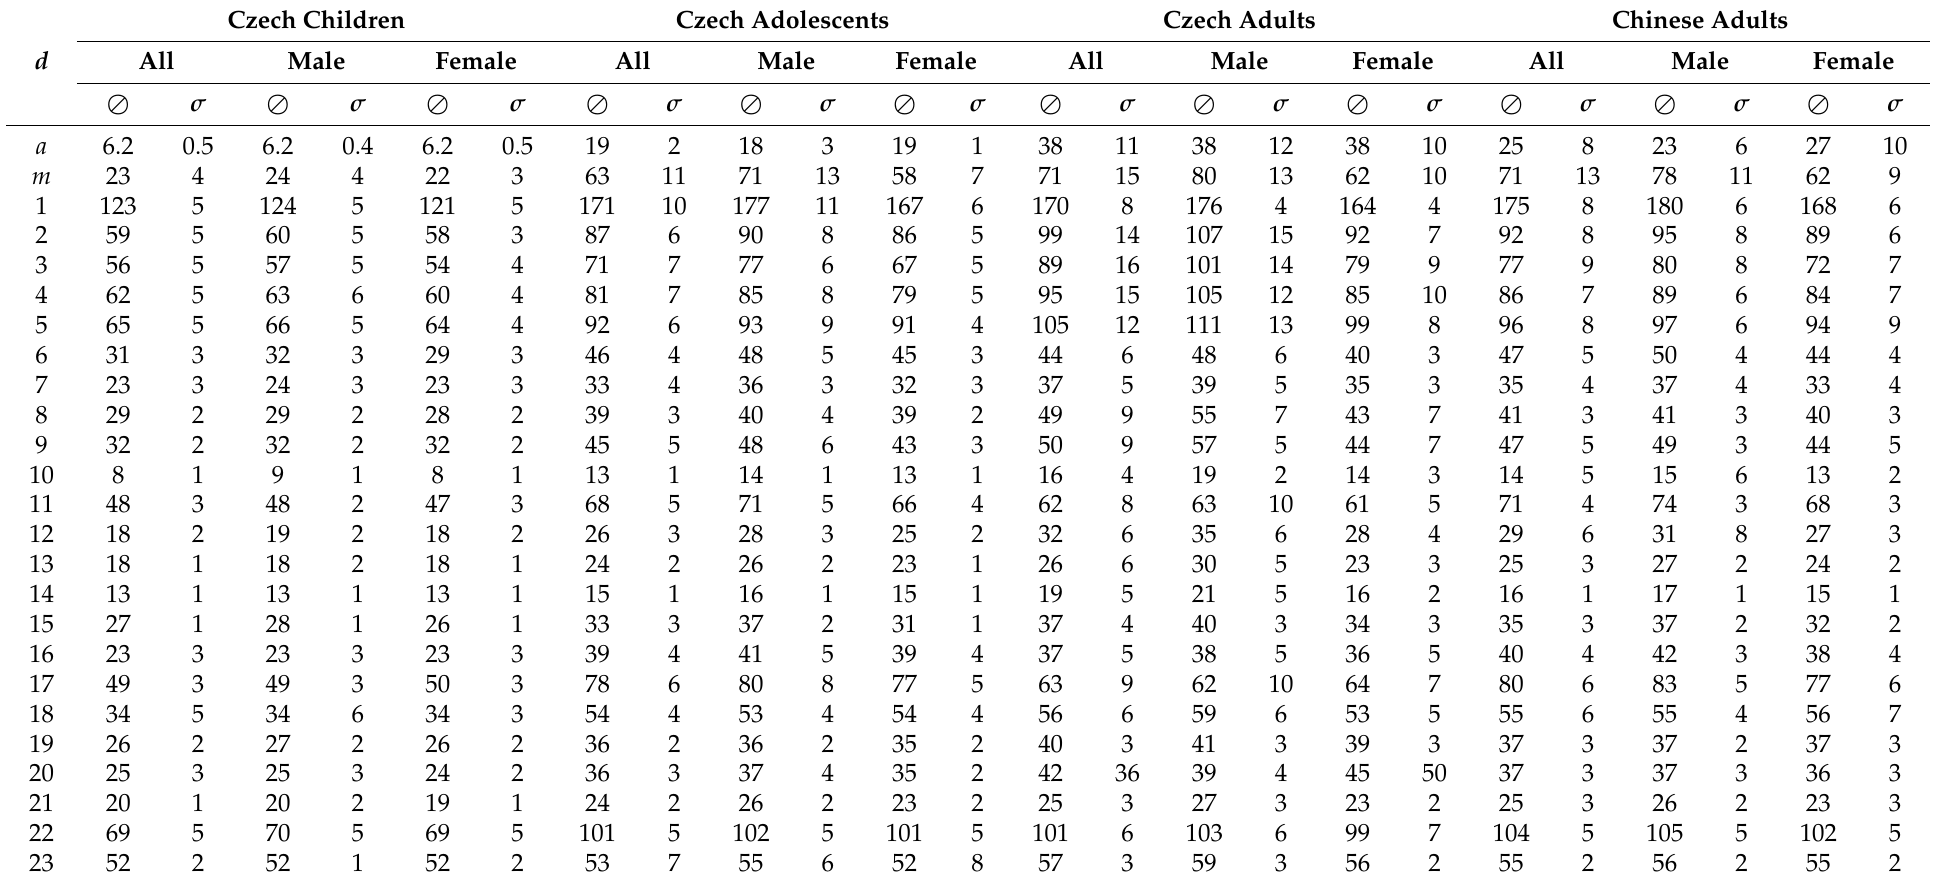
Table 5. Average dimensions. Mean value ( (cid:11) ) and the standard deviation ( σ ) for each dimension ( d ). The age ( a ) is reported in years, the mass ( m ) in kilograms, and the length dimensions in